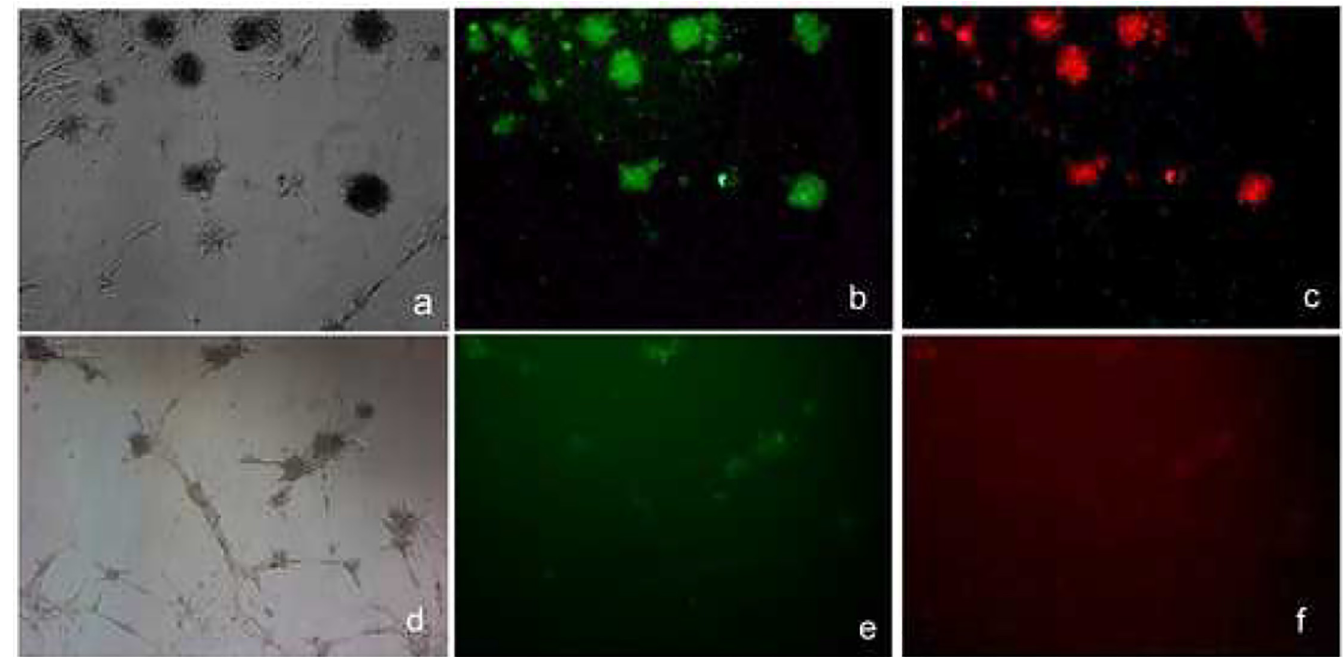
Fig 5. Anti CCL1 inhibits the expression of CCR8 and FoxP3 in mouse mesenchymal stem cells (mMSCs). Untreated (5a,-c) and anti-CCL1 treated (5d,-,f) cells were subjected to immunoflourescence with antibodies against FoxP3 (green;5b and e) or CCR8 (red;5c and f).